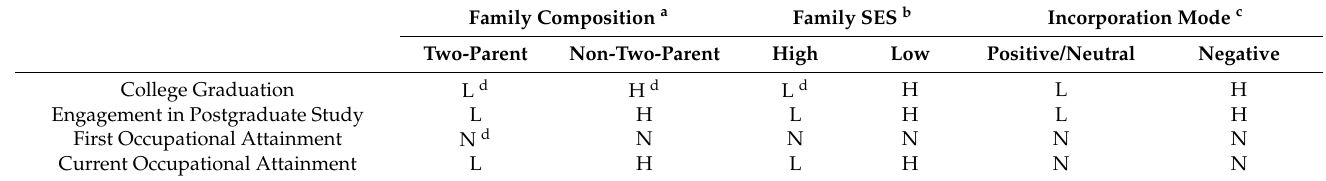
Table 1. Anticipated Conditional Effects of Mental Forces of Immigrant Children on Adaptation Outcomes across the Different Contexts of Family Composition, Family SES, and Incorporation Model in Young